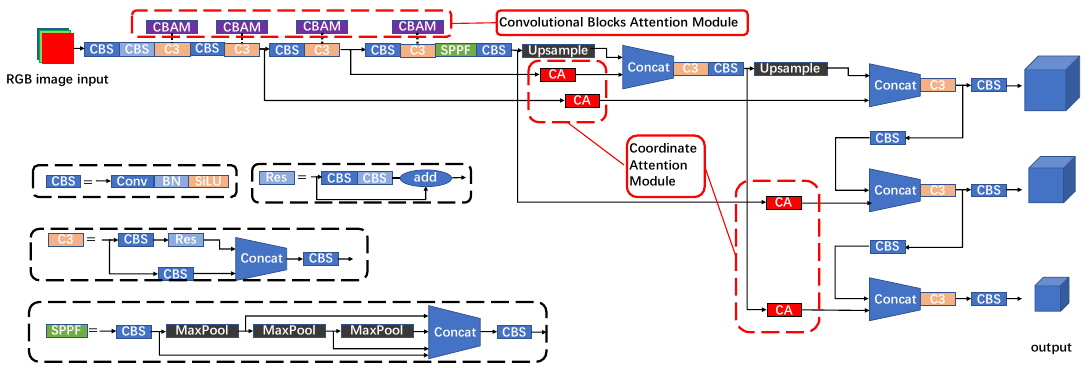
Figure 7. YOLO v5 structure diagram with attention modules.